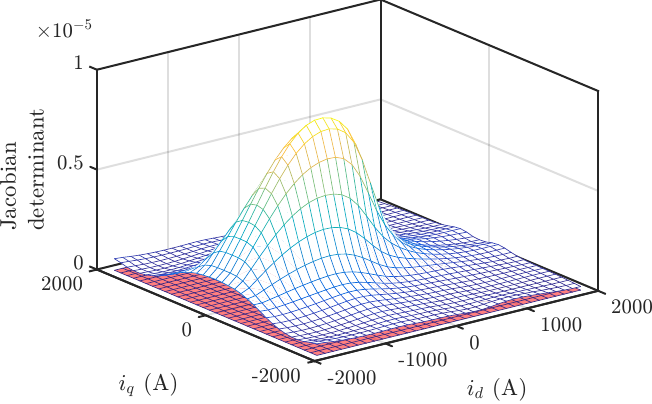
Figure 5. Jacobian determinant J f over the domain of current vectors I orig